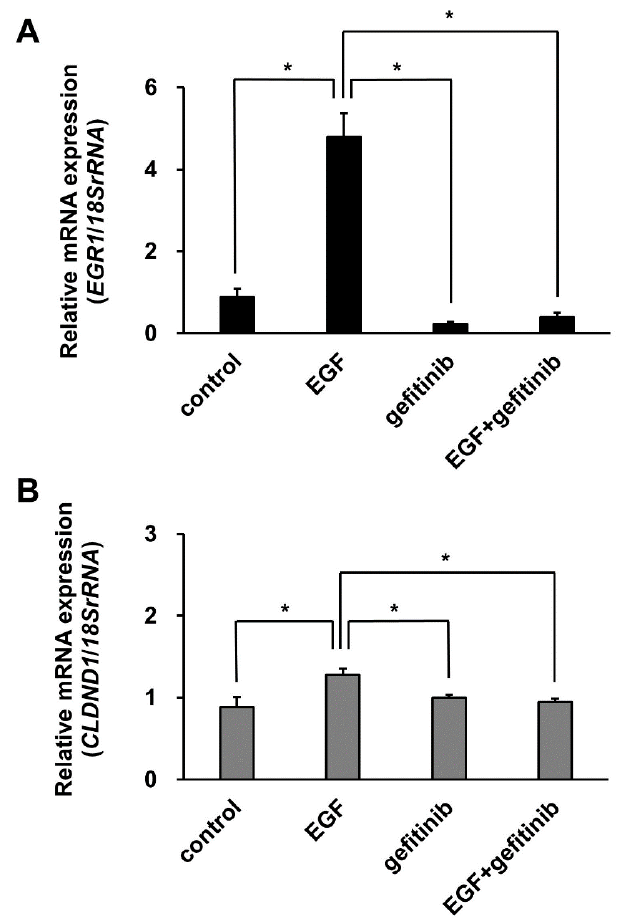
Figure 6. Effect of gefitinib treatment on CLDND1 expression. ( A ) HBECs were untreated or treated with 1 µ mol/L gefitinib for 60 min and then untreated or treated with 100 ng/mL EGF, and total